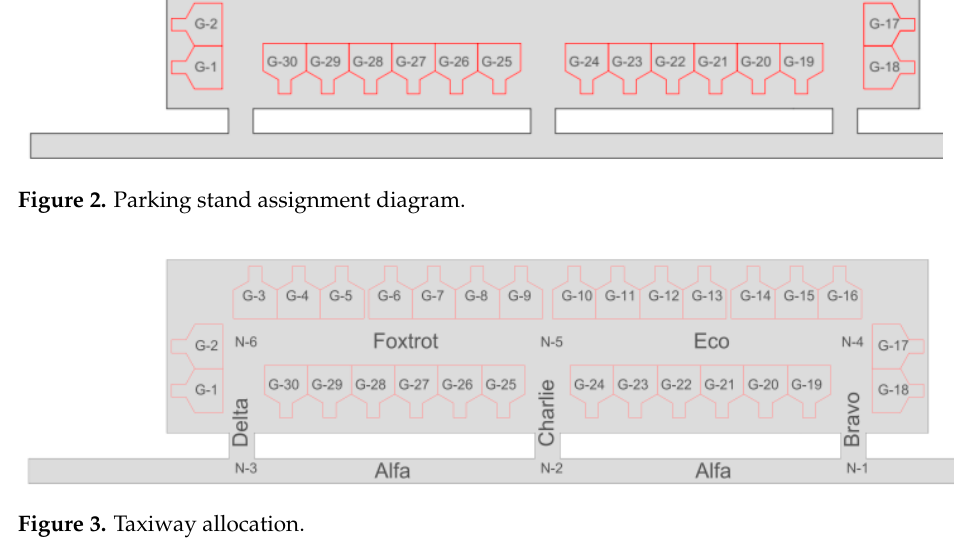
Figure 3. Taxiway allocation.